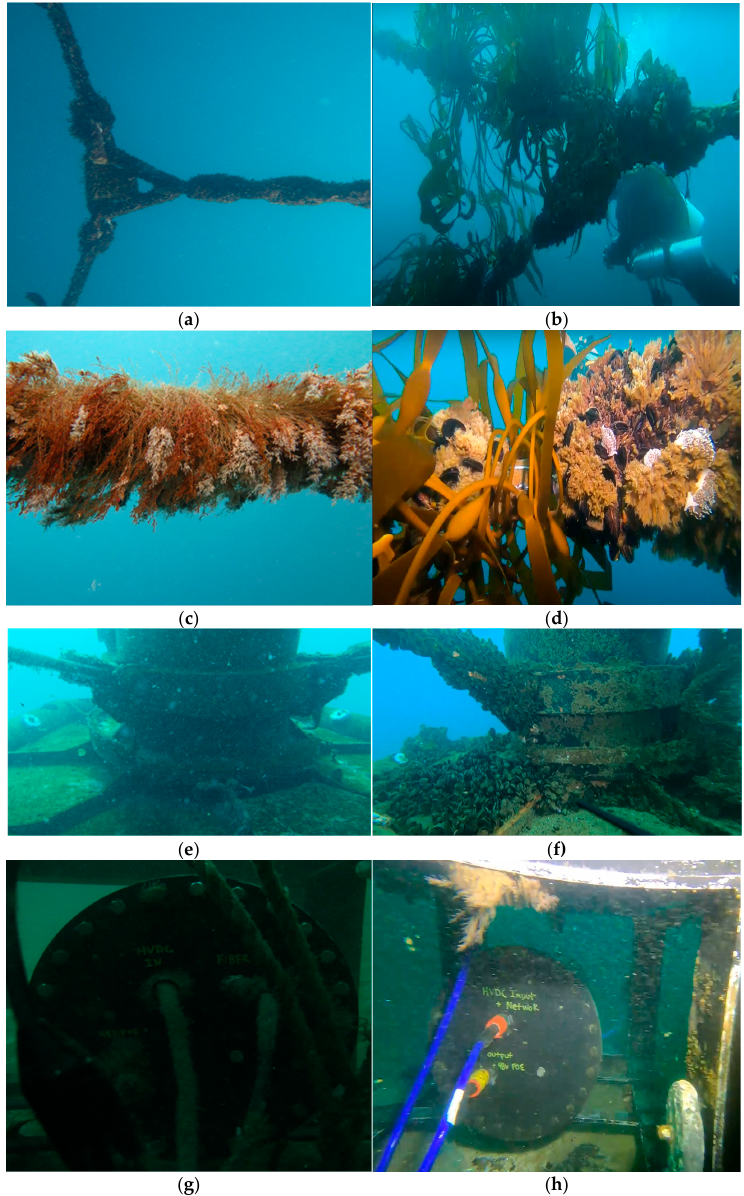
Figure 12. Images taken during two inspections 3 and 15 months after installation, including a triple mooring connector between the PB3 and the auxiliary buoys at a depth of 5 m in July 2021 ( a ) and July 2022 ( b ). Holding rope in July 2021 ( c ) and July 2022 ( d ). Balance plate in July 2021 ( e ) and July 2022 ( f ). First junction box at a depth of 34 m in July 2021 ( g ) and July 2022 ( h ).